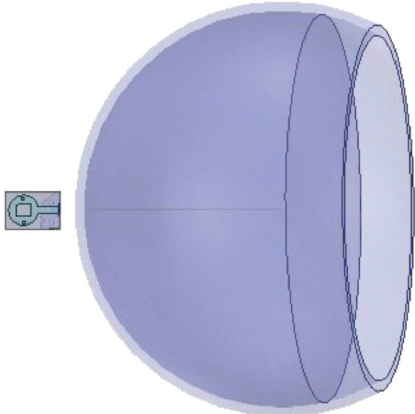
Figure 10: The simulation model of the human brain.